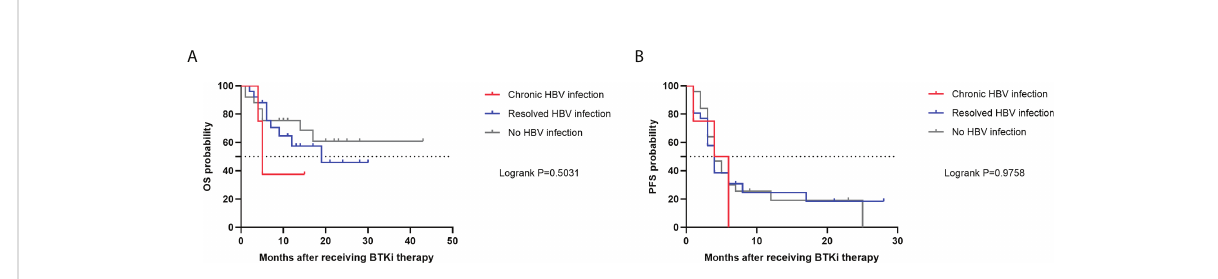
FIGURE 3 OS (A) and PFS (B) in R/R DLBCL patients after receiving BTKi therapy. OS, overall survival; PFS, progression-free survival; HBV, hepatitis B virus; BTKi, Bruton tyrosine kinase inhibitor; R/R DLBCL, relapsed or refractory diffuse large B-cell